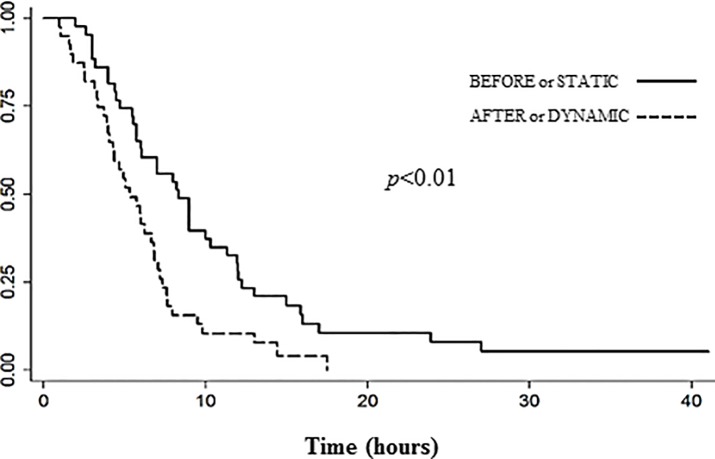
Time to reach the glycemic target demonstrating the efficacy of a dynamic algorithm.Fifty percent of patients achieved the glycemic target in 8.3 hours [4.7; 12.2] during P1 «static protocol» vs in 5.3 hours [3.4; 7.3] during P2 «dynamic algorithm».